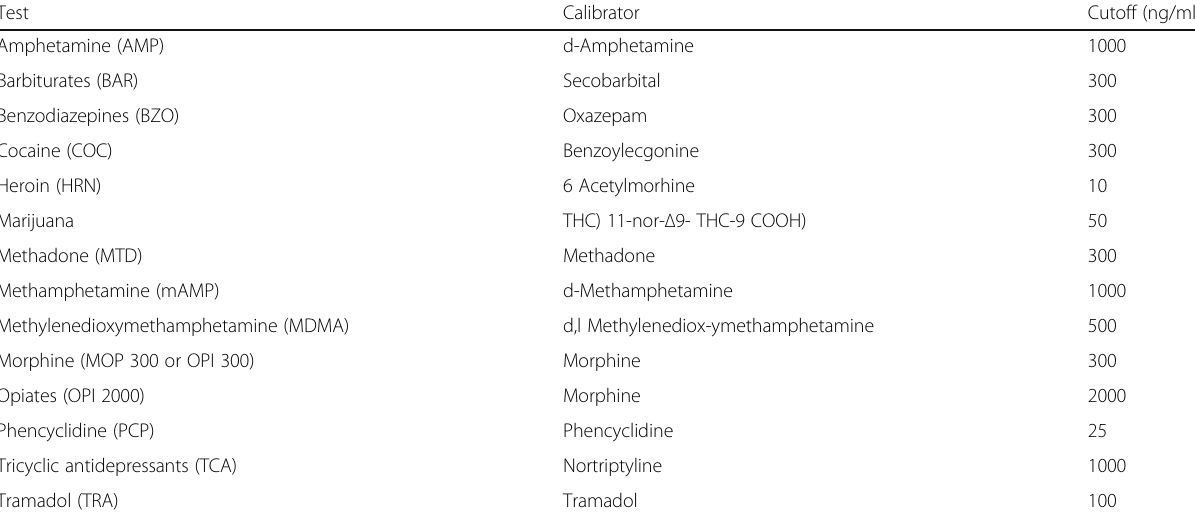
Table 1 The cut off value of the One Step Screen Test panel for urine (according to the kit